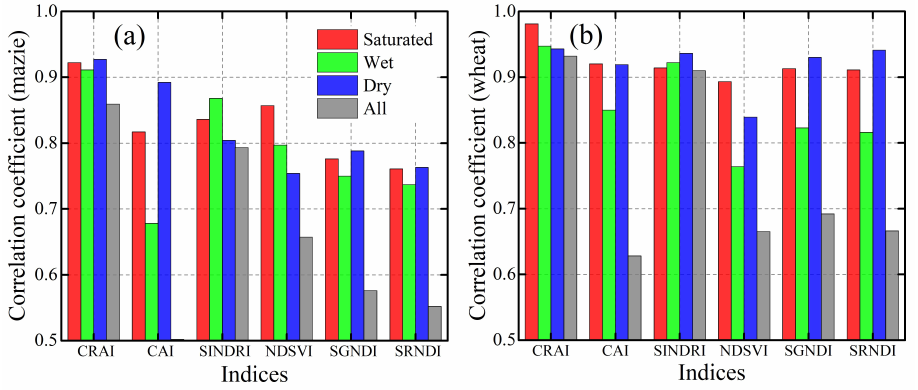
Figure 7. Absolute value of correlation coefficient between: (i) CRC and (ii) CRAI, CAI, SINDRI, NDSVI, SGNDI, and SRNDI for the different datasets for maize ( a ) and wheat ( b ) (see legend).